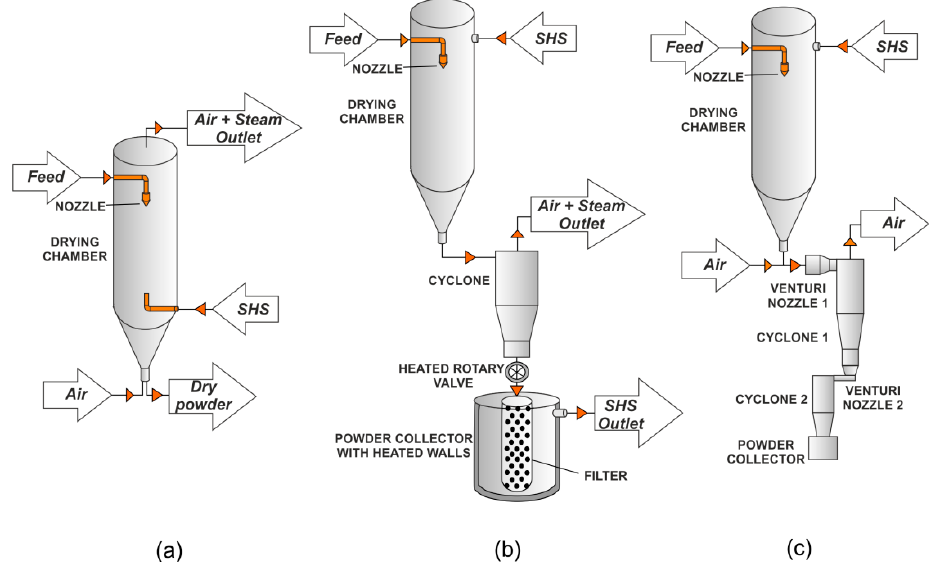
Figure 3. Scheme of SHS spray dryers with different methods of product collection: ( a ) air supply to the conical part of the dryer [51]; ( b ) powder collector with heated walls and filter [56]; ( c ) use of venturi nozzle and double cyclone separation stage [57].